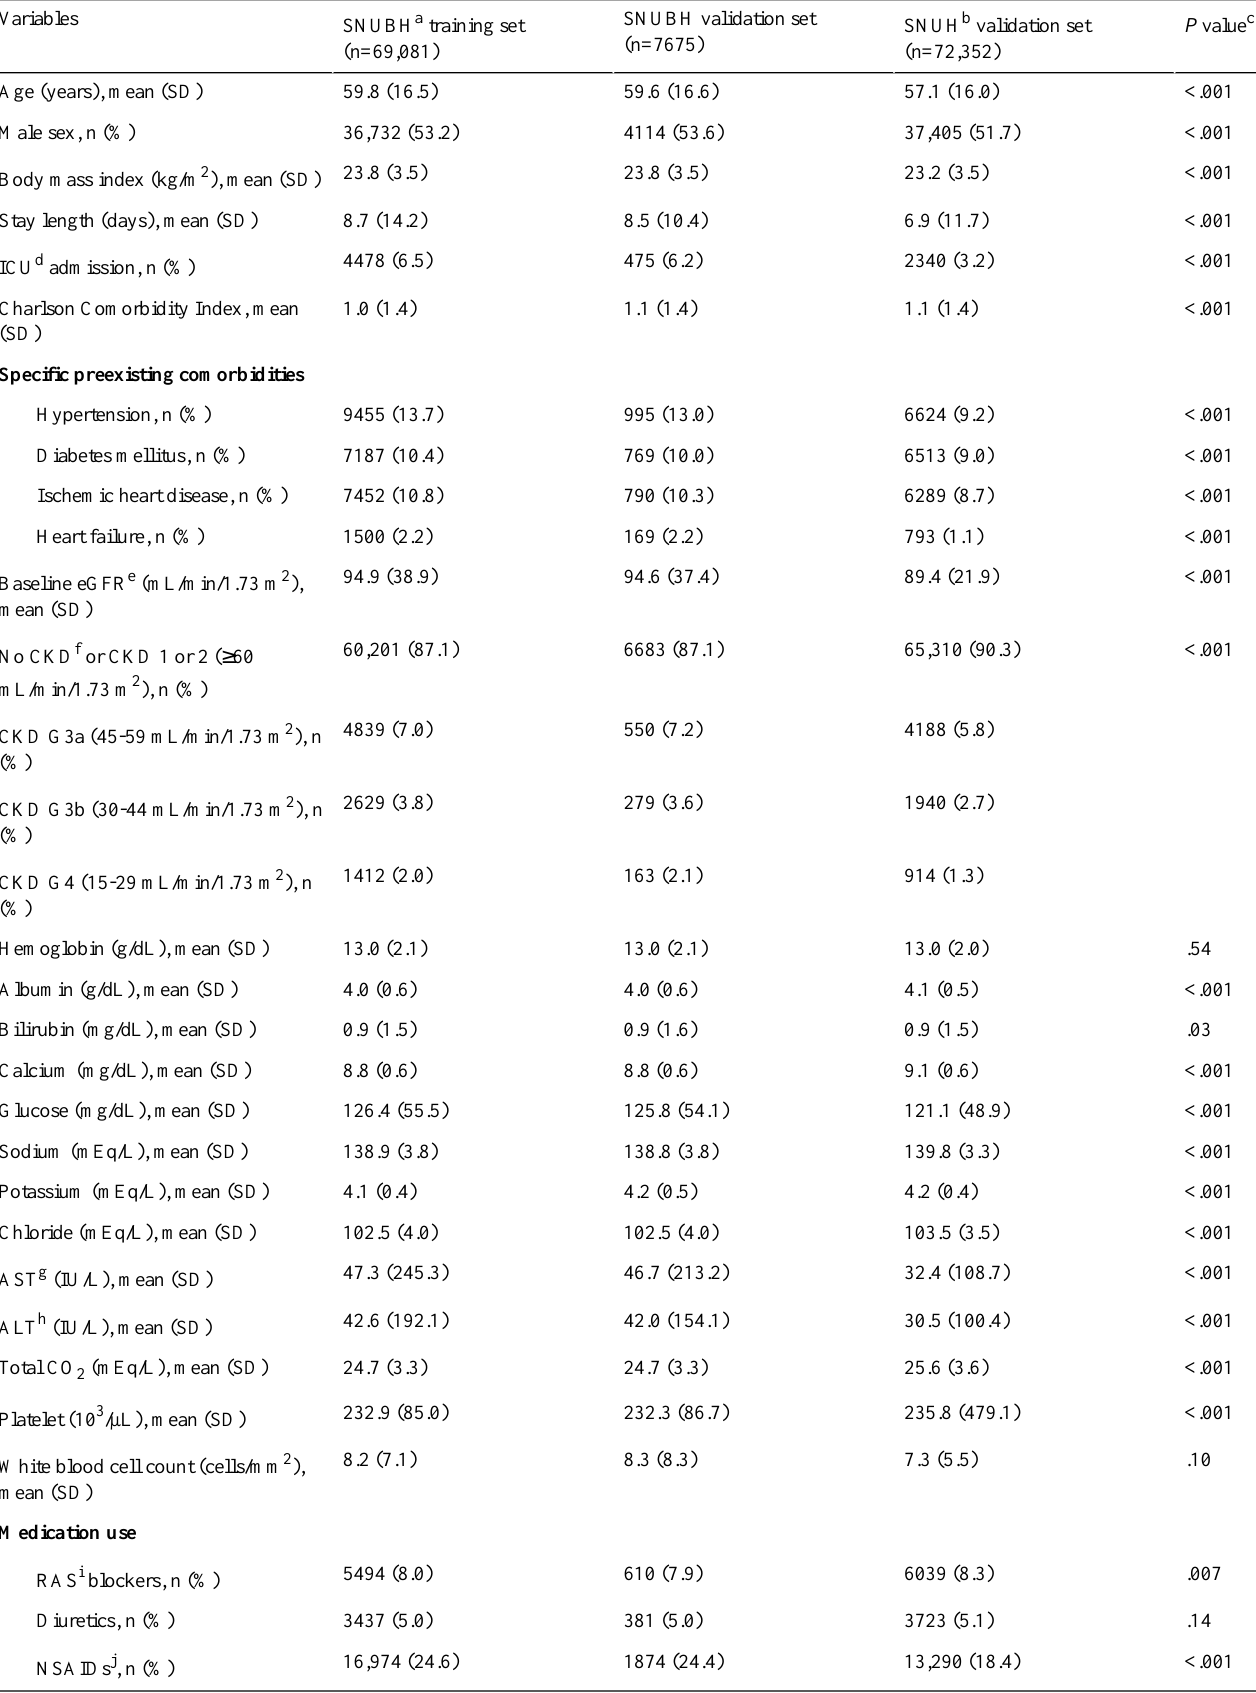
Table 1. Baseline characteristics of the training and validation data